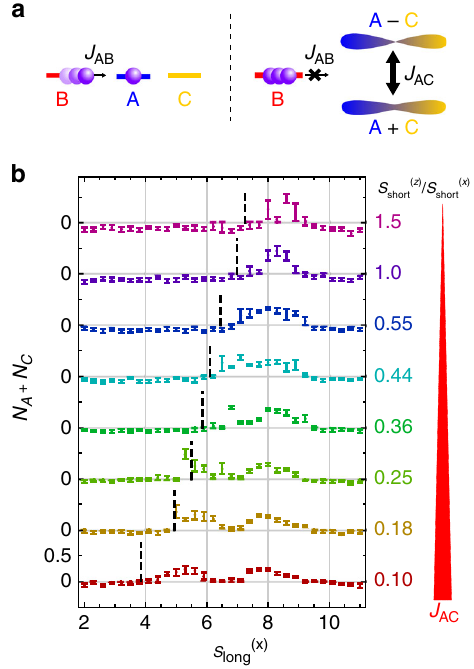
Fig. 4 Analogue EIT experiment. a Schematic of the experiment. (left) In the absence of J AC , the weak tunneling coupling J AB results in a fraction of atoms in A . (right) In the presence of strong J AC , tunneling only occurs when the energy resonates to bonding A + C or antibonding A − C orbitals, split by coupling J AC . b Tunneling spectrum after a hold time of 1.8 ms, at Þ ; ð s ð x Þ ; 8 Þ ; 9 : 5 (cid:3) with ψ = (1 ∕ 2 + 0.07) π . the lattice depths of ½ð 40 ; s ð z Þ short long Fraction of atoms which tunnel from the B -sublattice is shown. Vertical dashed lines show the rough estimation of the points where E A = E B is satis fi ed, based on a harmonic approximation of the lattice potential. Error bars represent standard